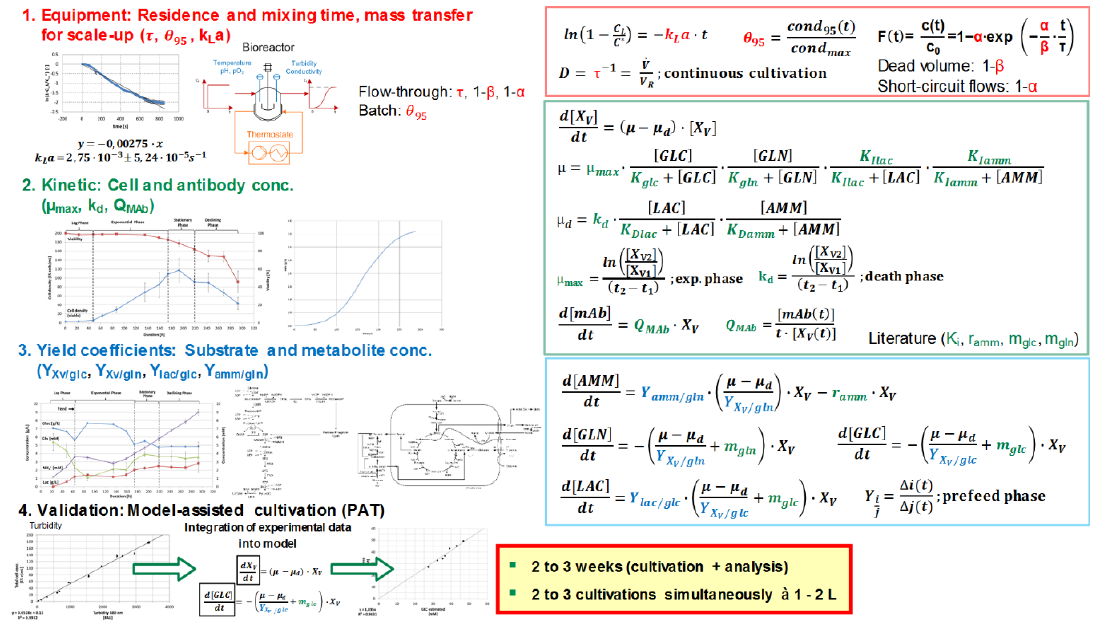
Figure 4. Schematic workflow overview for the model parameter determination concept in upstream process modelling. Detailed description can be found in the literature [2,11,13,14,45,46]. Red-marked parameters (volumetric mass transfer coefficient k L a , mixing time θ 95 , as well as residence time) lead to the characterization of the equipment. Kinetic (green-marked) and equilibrium (blue-marked) parameters can be obtained by cultivations. For validation, similar experiments can be used. Efforts for the generation of this data are commonly 2 to 3 weeks for two to three simultaneously run cultivations in 1 to 2 L and their respective analysis. GLC, glucose, GLN, glutamine; LAC, lactate; AMM, ammonium, PAT, process analytical technology.